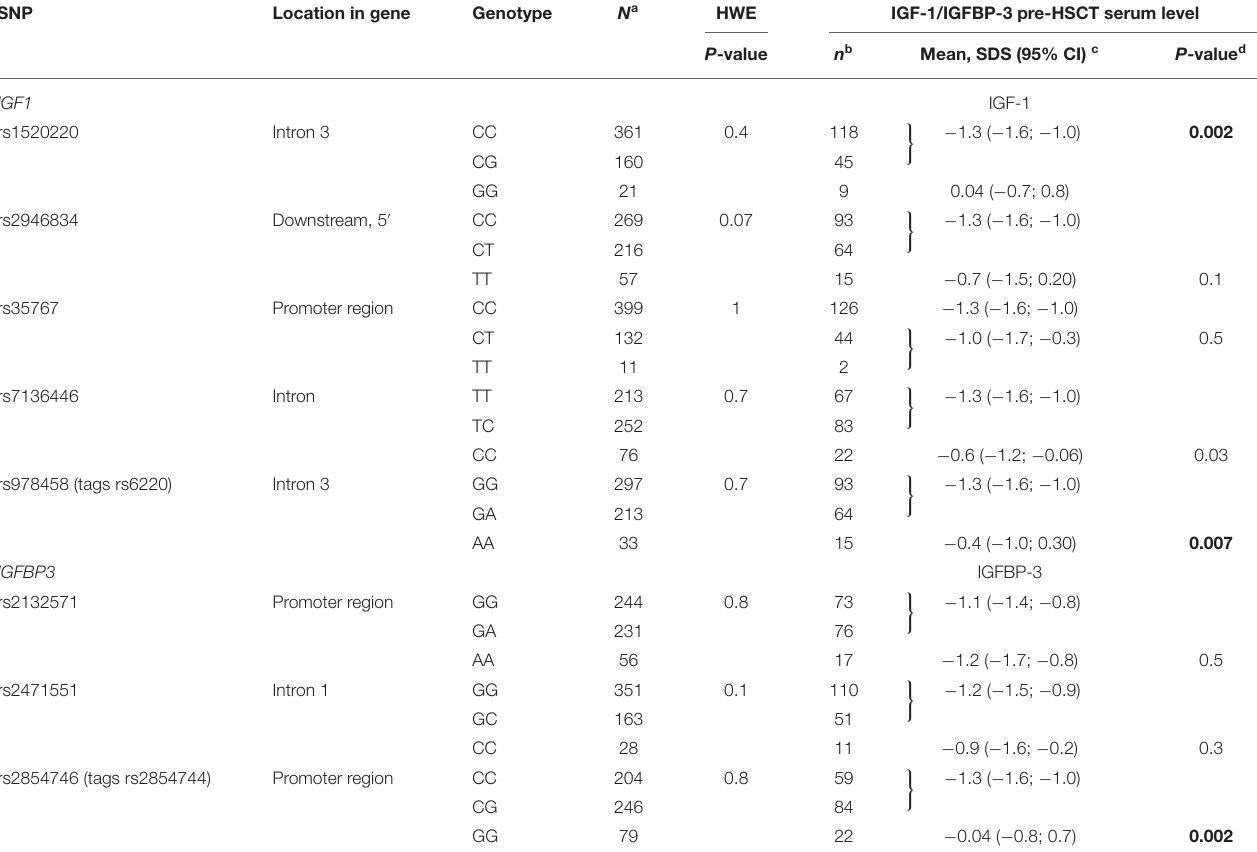
TABLE 2 | Genotypes of IGF1 and IGFBP3 and association with circulating IGF-1 and